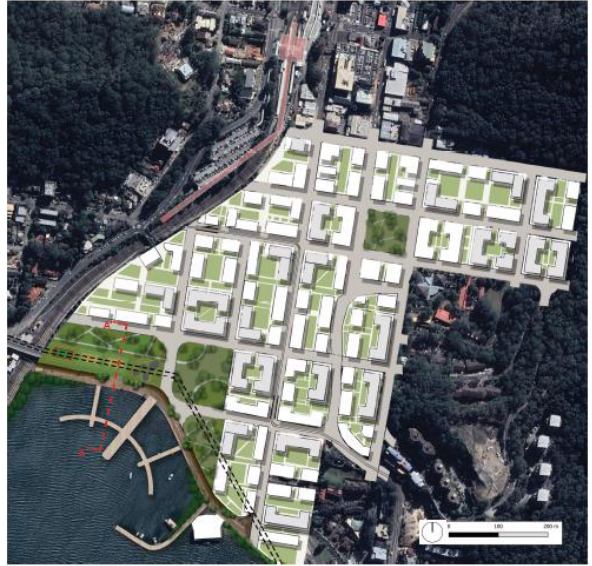
Figure 5: The hybrid scenario developed for Gosford town centre.